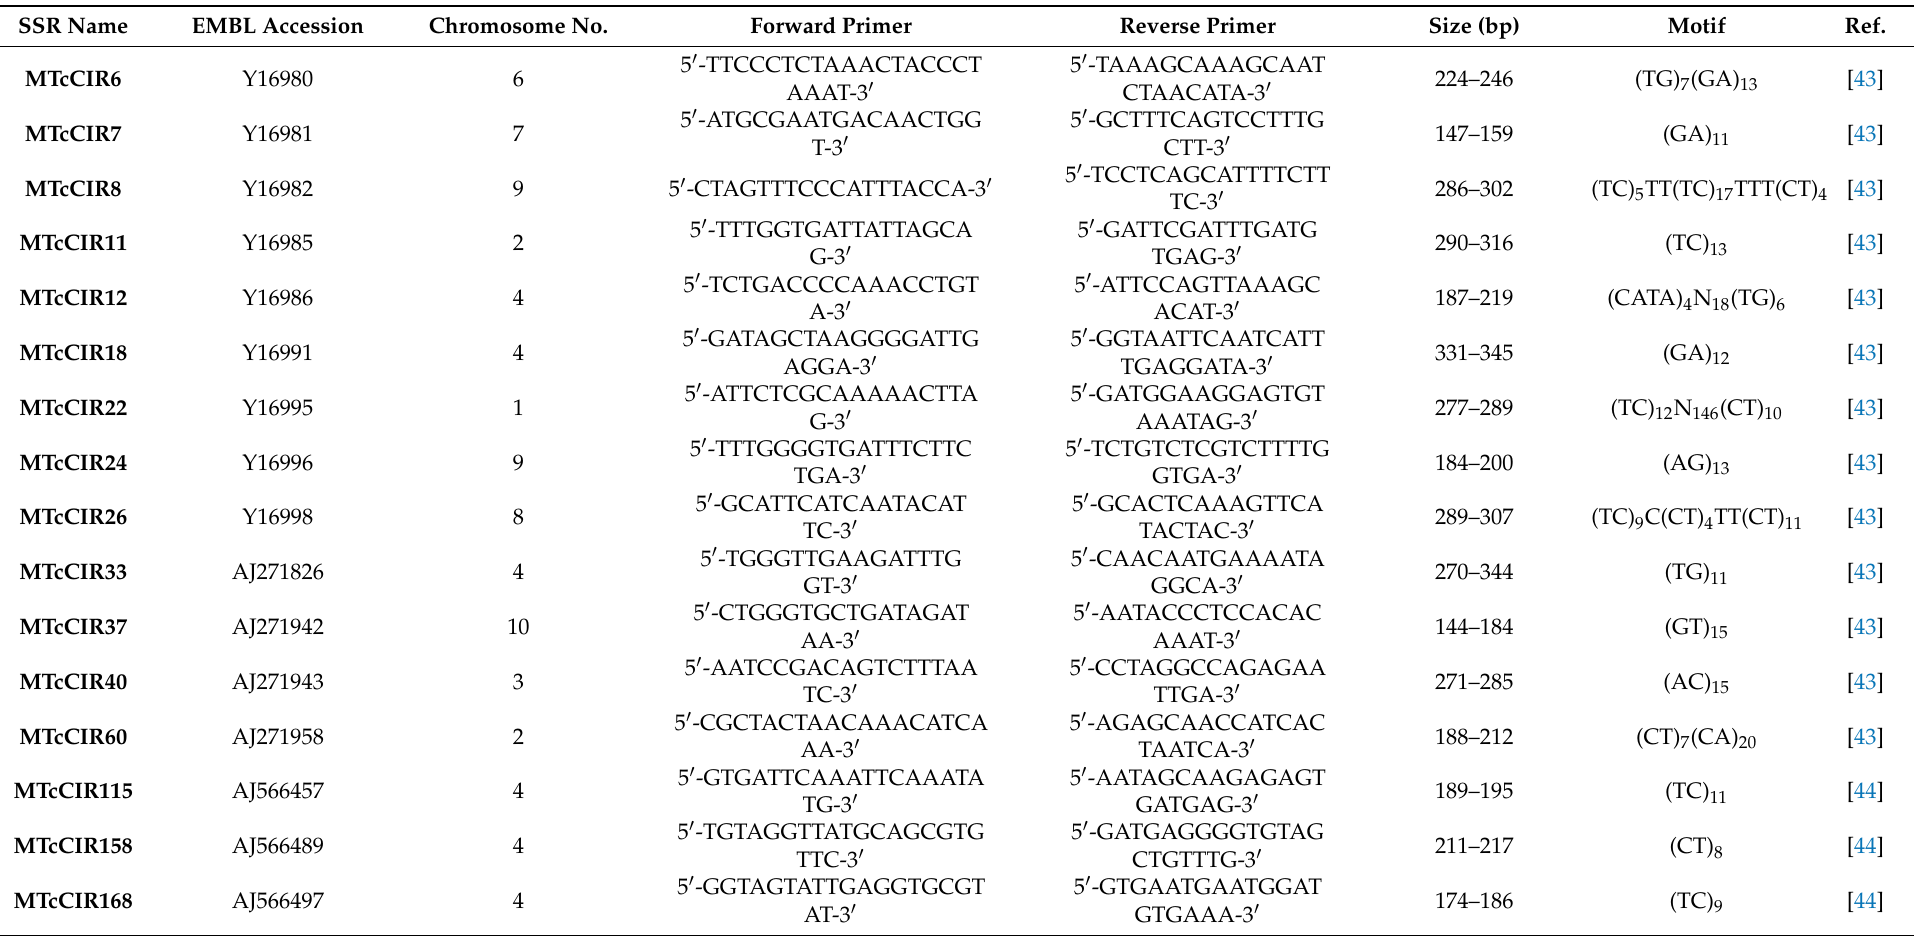
Table 1. List of the 16 SSR loci used for the analysis of the cacao samples: SSR names, EMBL accessions, chromosome number, forward and reverse primer sequences, observed size, repeat motifs, and